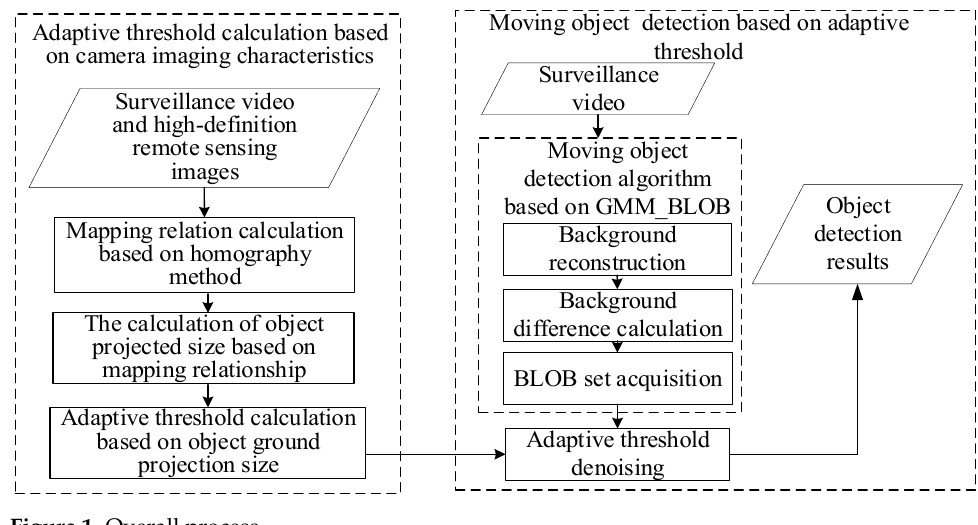
Figure 1. Overall